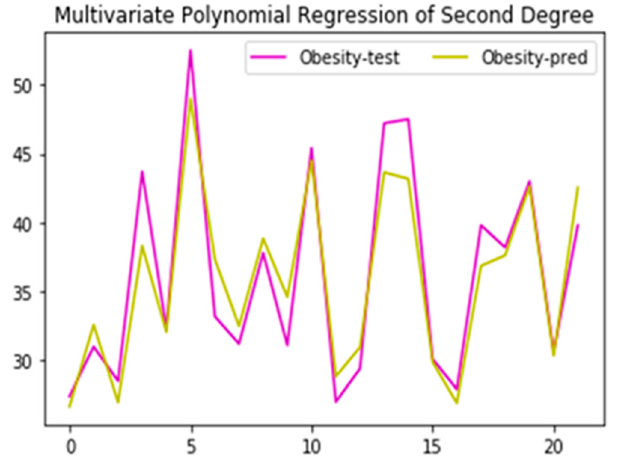
Figure 11. Multivariate polynomial regression of second